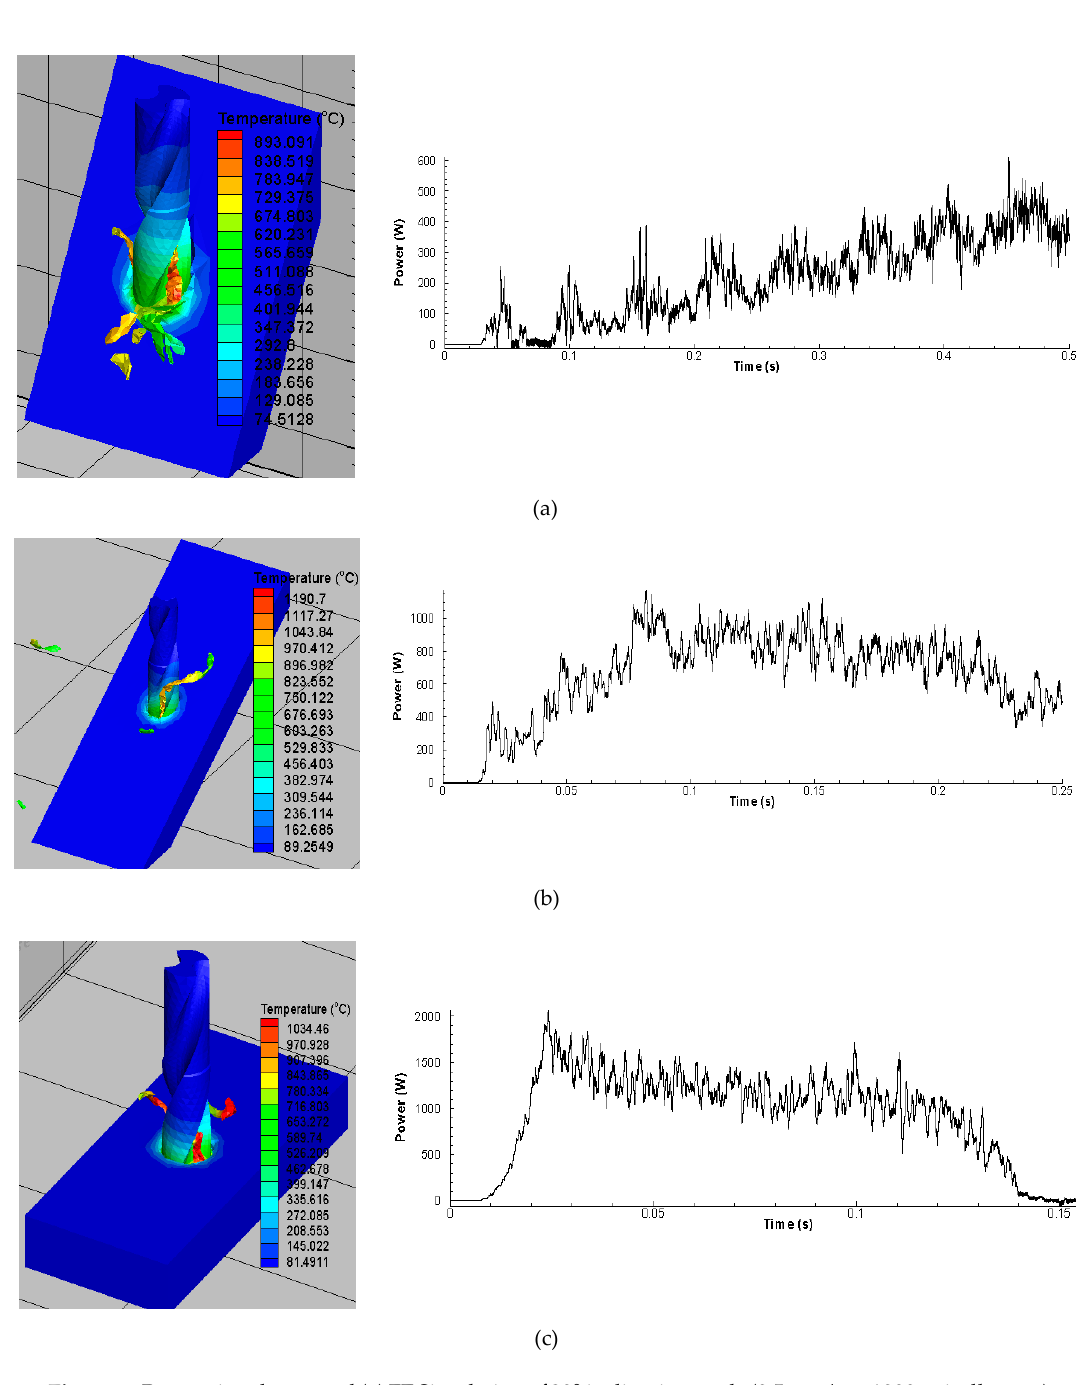
Table 8. The measured cutting power responses and the corresponding signal to noise ratios.